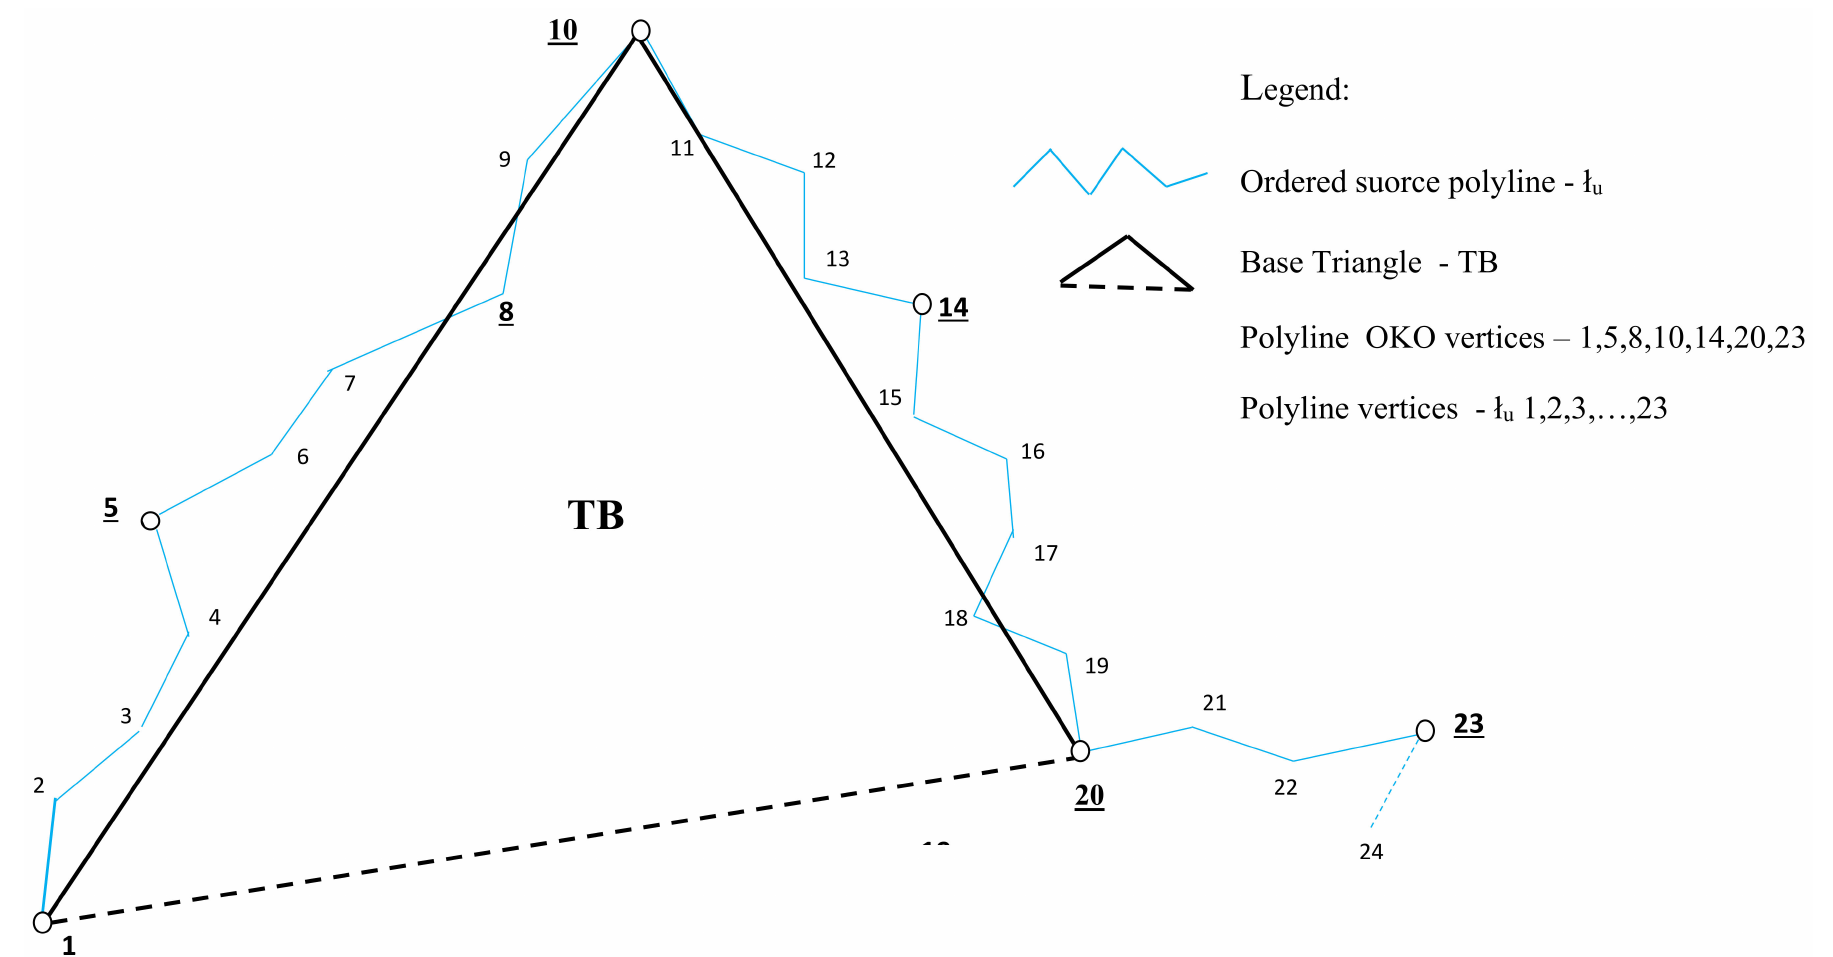
Figure A2. Ordered source line— l u with base triangle—TB. Scale